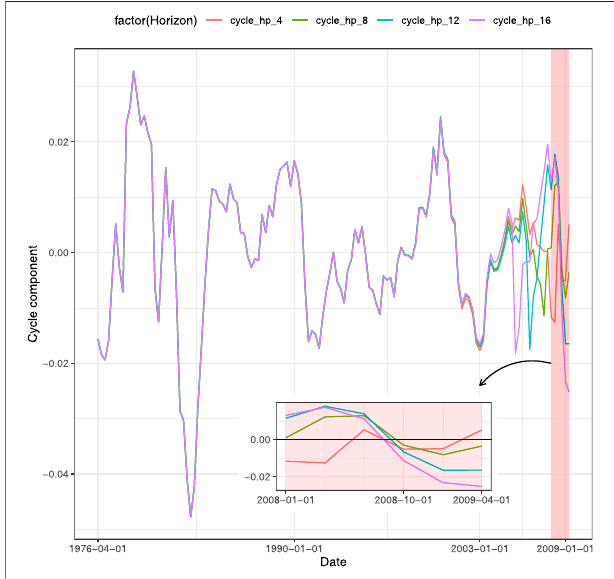
FIGURE 1 | Cycle decomposition of GDP, sensitiveness to different horizons until last quarter of 2020.